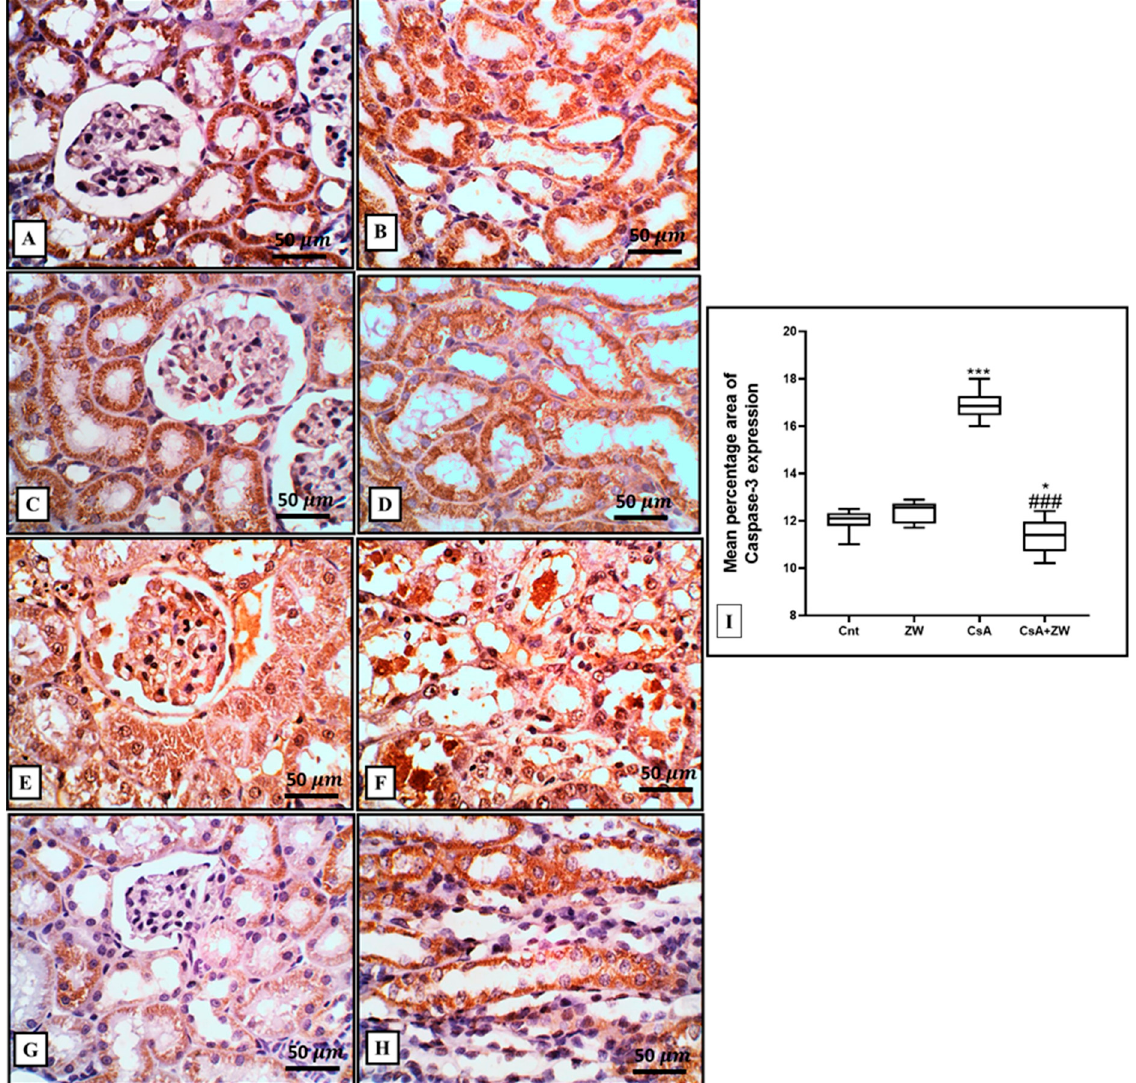
Figure 4. Immunohistochemical analysis of caspase-3 expression and localization in the kidney. ( A – D ) The control and ZW groups show cytoplasmic expression in the normal cortical and medullary tubular epithelium. ( E , F ) The CsA group shows di ff use, strong expression in the glomerulus, in the cytoplasm of necrotic and vacuolated cortical and medullary tubular cells, and in the cytoplasm of vacuolated and intraluminal cells. ( G , H ) The CsA + ZW group shows moderate cortical and medullary tubular expression. ( I ) Kidney caspase 3 histogram. *** p < 0.001, and * p < 0.05 vs. control ; ### p < 0.001 vs. CsA. Image magni fi cation = 400×; scale bar = 50 µm.